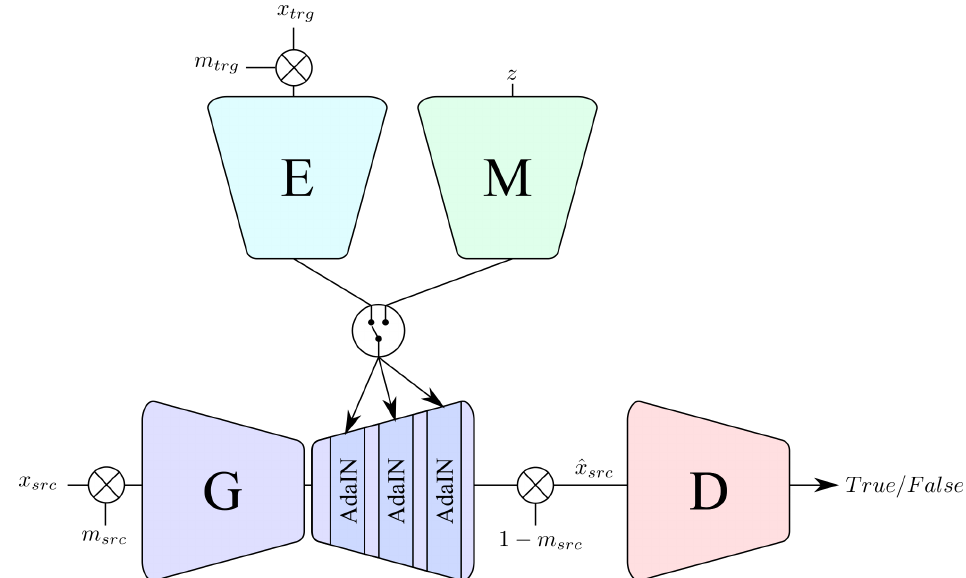
Figure 1. Overview of the proposed system. Firstly, the input image x src is multiplied with its corresponding mask m src and fed to the generator G . Then, AdaIN parameters are extracted from either E or M and injected in the normalization layers of G . Finally, the generator output is multiplied again with the inverted mask and used as input to the discriminator D